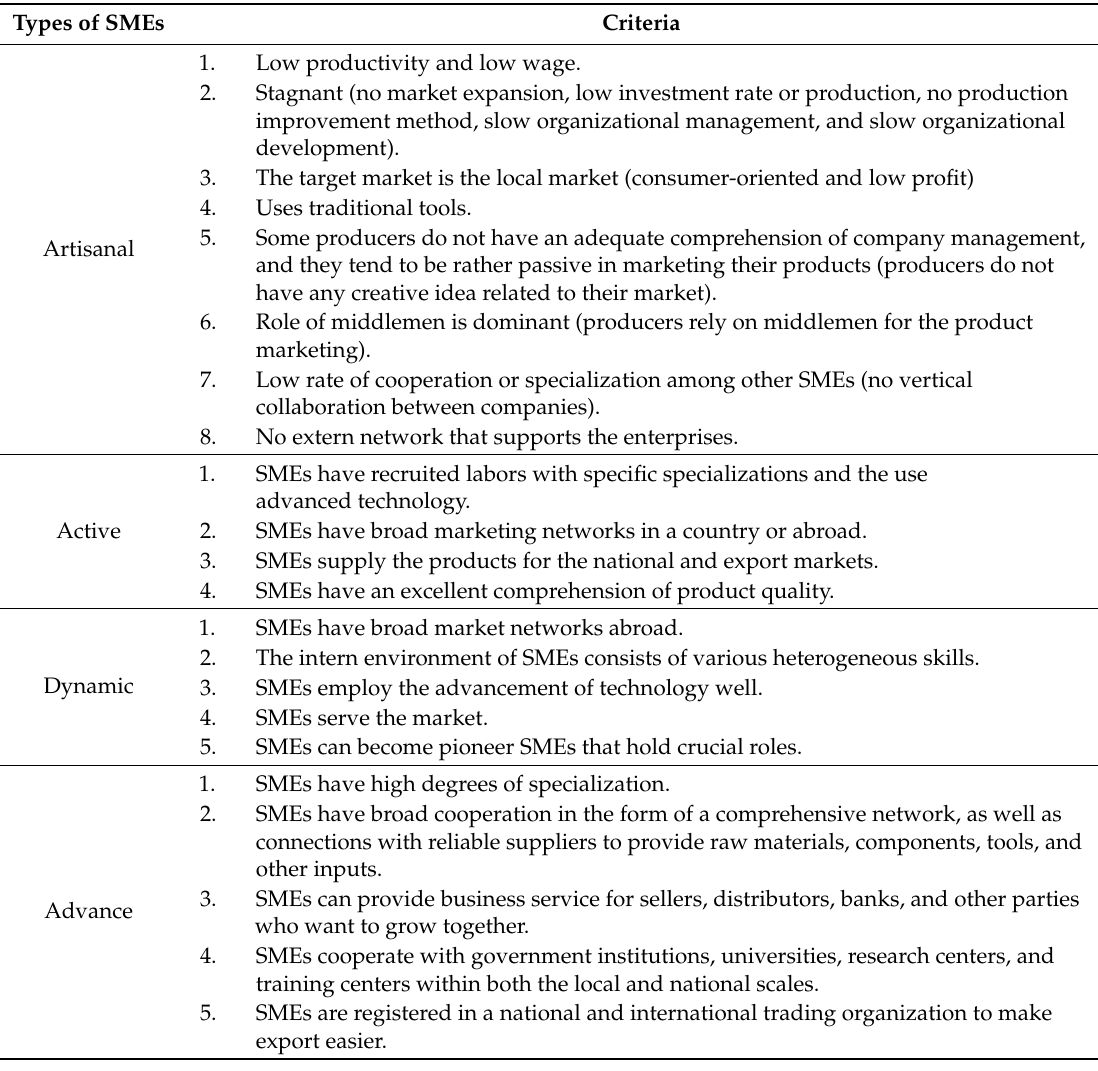
Table 2. The characteristics of SMEs in